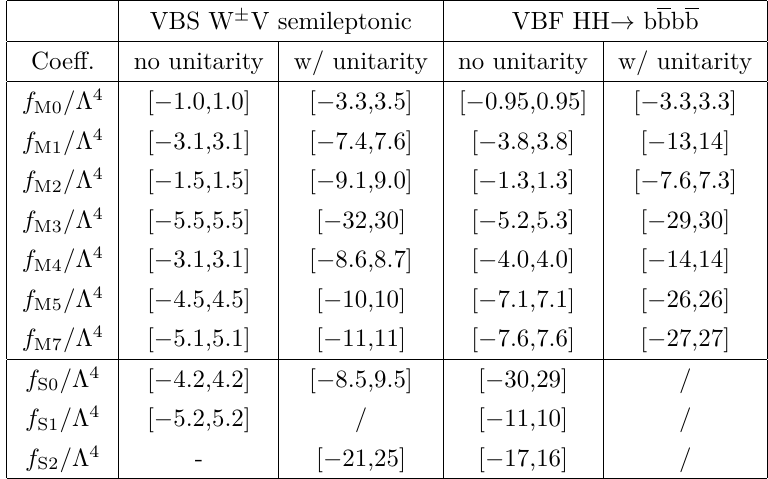
Table 4 . Comparison between VBF-HH constraints and those obtained from semileptonic VBS with or without unitarity constraints, with limits extracted from current CMS Run2 analyses. All entries represent 95% CL lower and upper limits in units of TeV − 4 . Bars represent processes for which there is no sensitivity to the corresponding operator, or cases where the theoretical unitarity bound is more stringent than the experimental one for all m cut-off values. max